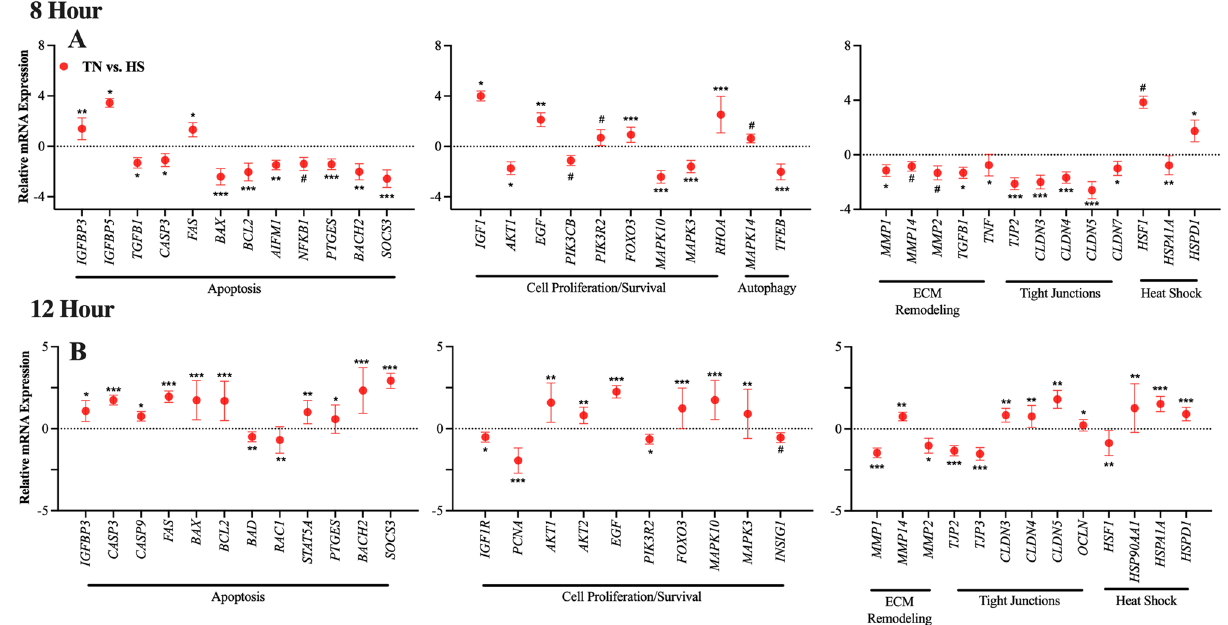
Figure 1. Main effect of temperature. Gene expression of primary bovine mammary epithelial cells (pBMEC) after 8- or 12-h incubation at thermoneutral (37 °C, TN) or heat shock (41.5 °C, HS) culture conditions. Data is presented as relative mRNA expression (∆∆Ct = ∆Ct TN (CON) − ∆Ct HS)) ± standard error of the mean (SEM). Differentially expressed genes are grouped by biological function. After 24-h incubation at HS conditions, 9 genes ( PTGES , 5-HT2C , ATG3 , AKT1 , PIK3R2 , PRKACA , TNF, CLDN1 , OCLN ) were differentially expressed, relative to TN (graph panel not shown). Positive and negative ∆∆Ct indicates gene upregulation and downregulation, respectively. Significance declared at (*) P value ≤ 0.05, (**) P value ≤ 0.001 (***) P value ≤ 0.0001 and (#) denotes a statistical tendency at 0.05 < P value ≤